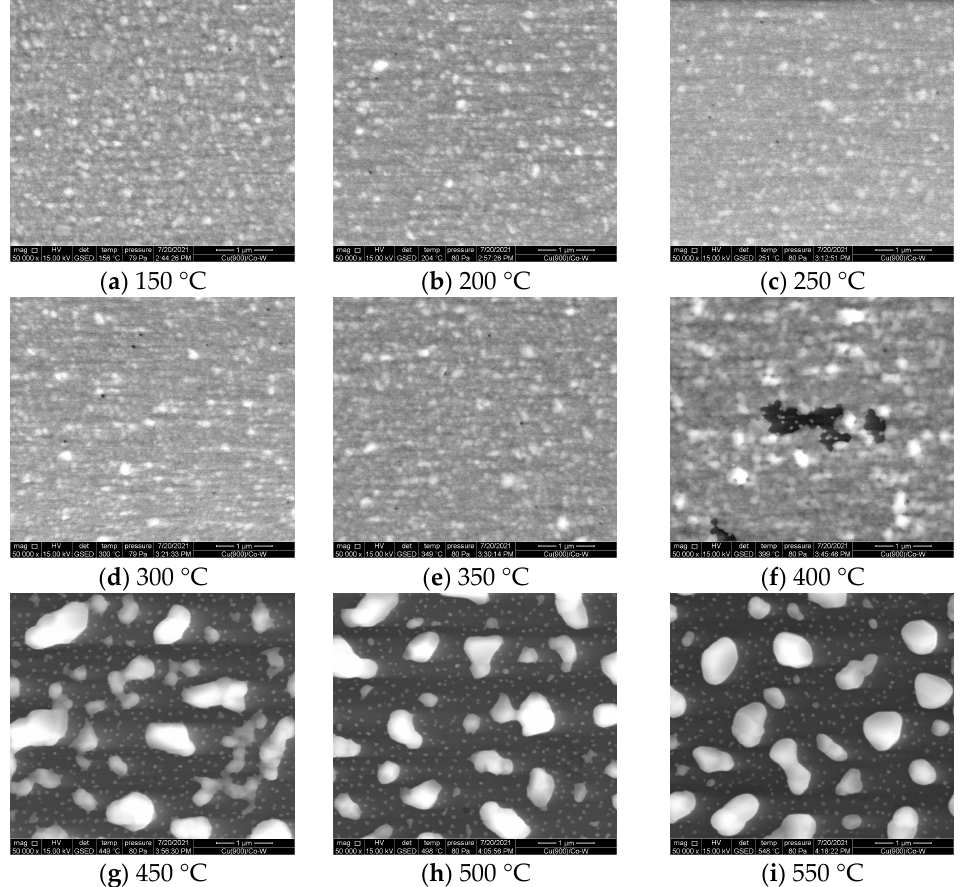
Figure 4. Surface of the Cu film deposited over a Co-W layer from 150 °C ( a ) to 550 °C ( i ), using a 30 °C/min. heating rate.